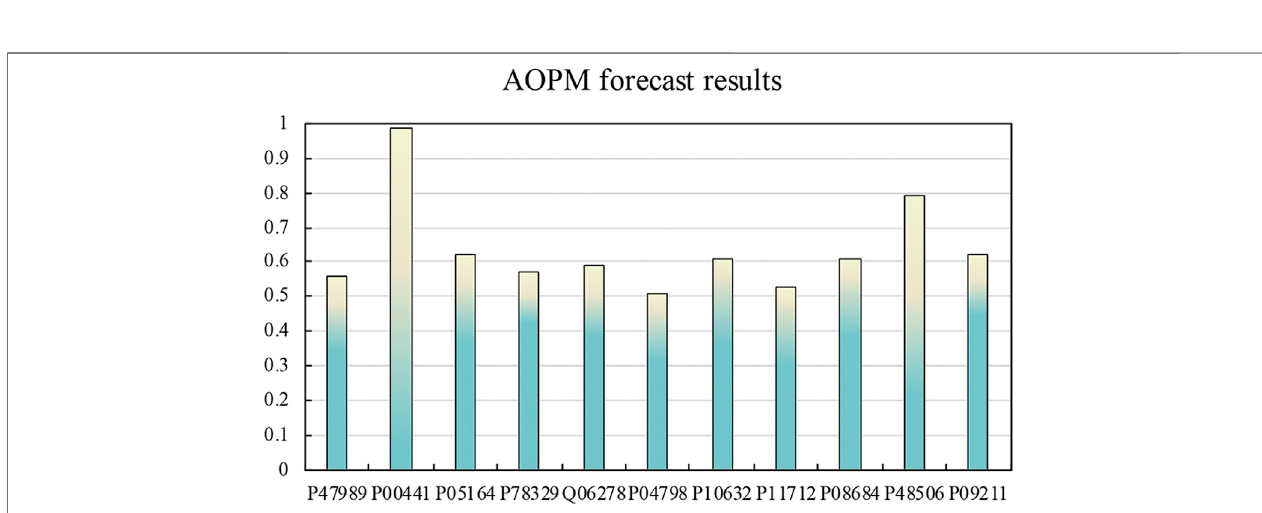
FIGURE4| Theclassi fi cationresultsofthestate-of-artmethodsonthetestdataset.TheSN,ACC,andAUCofAOPMwere0.873,0.920,and0.972,respectively. That was much higher than that of AodPred and Zhai, whose SN was higher than 0.99 and 0.204, respectively.